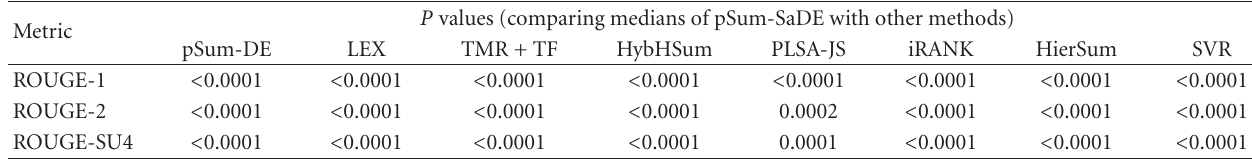
Table 7: P values produced by Wilcoxon’s rank sum test by comparing pSum-SaDE with other methods. P values (comparing medians of pSum-SaDE with other Metric